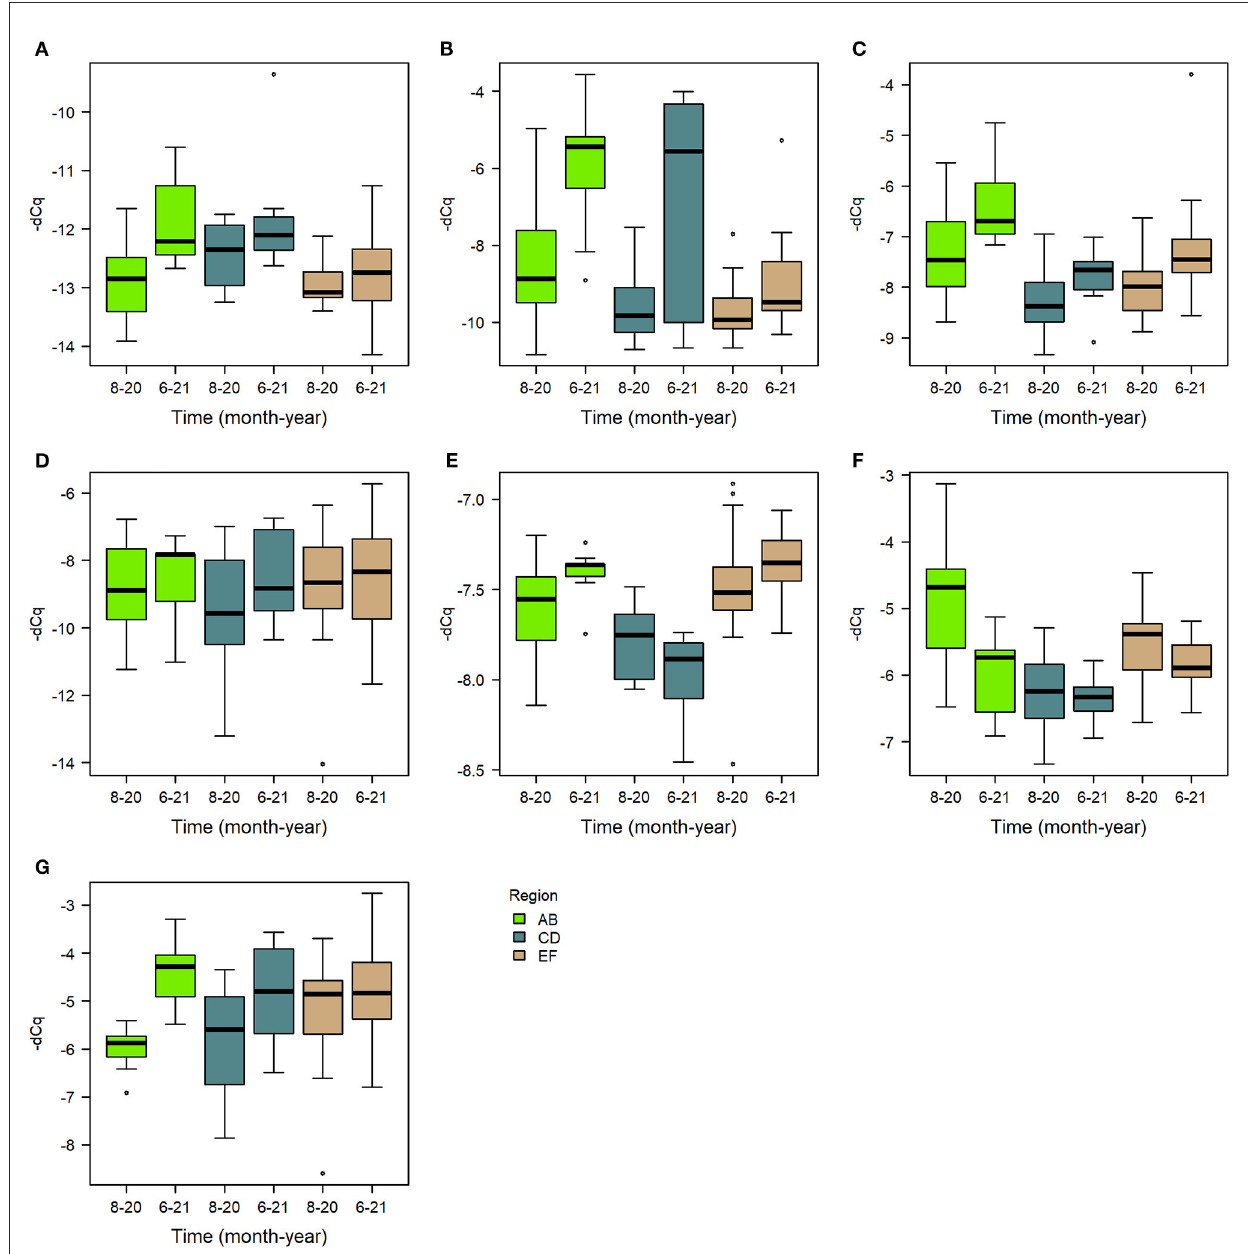
FIGURE6 Boxplots of gene expression levels of the assayed genes (A) apidaecin , (B) hymenoptaecin , (C) PEPCK , (D) peritrophin , (E) PGRP-LC , (F) PPO , and (G) trynity , in August 2020 and June 2021 in each region.